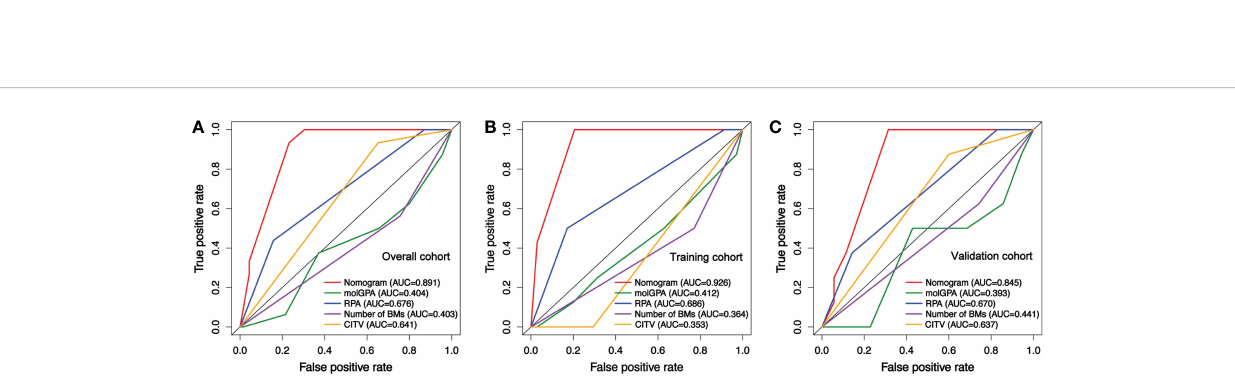
FIGURE 7 Receiver operating characteristic curves (ROC) comparing the predictive value of the nomogram with lung-molGPA, RPA models, cumulative intracranial tumor volume (CITV), and number of BMs for the prognosis of NSCLCBM patients. (A) In the overall cohort, (B) in training, and (C) in validation